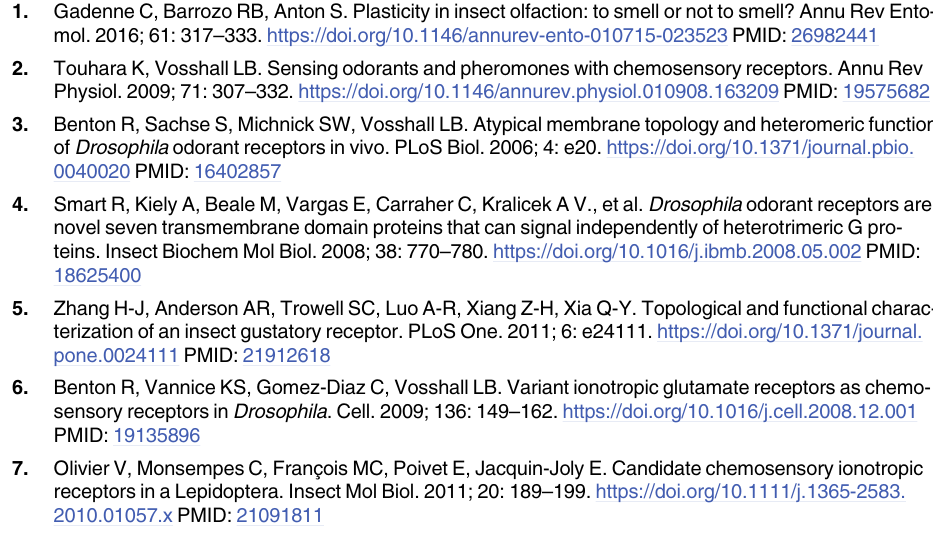
S5 Table. Candidate sensory neuron membrane protein (SNMP) in Callosobruchus macu- latus identified from the de novo antennal transcriptome data. S6 Table. Candidate odorant-binding protein (OBP) in Callosobruchus maculatus identi- fied from the de novo antennal transcriptome and previous genomic construction data. S7 Table. Candidate chemosensory protein (CSP) in Callosobruchus maculatus identified from the de novo antennal transcriptome and previous genomic construction